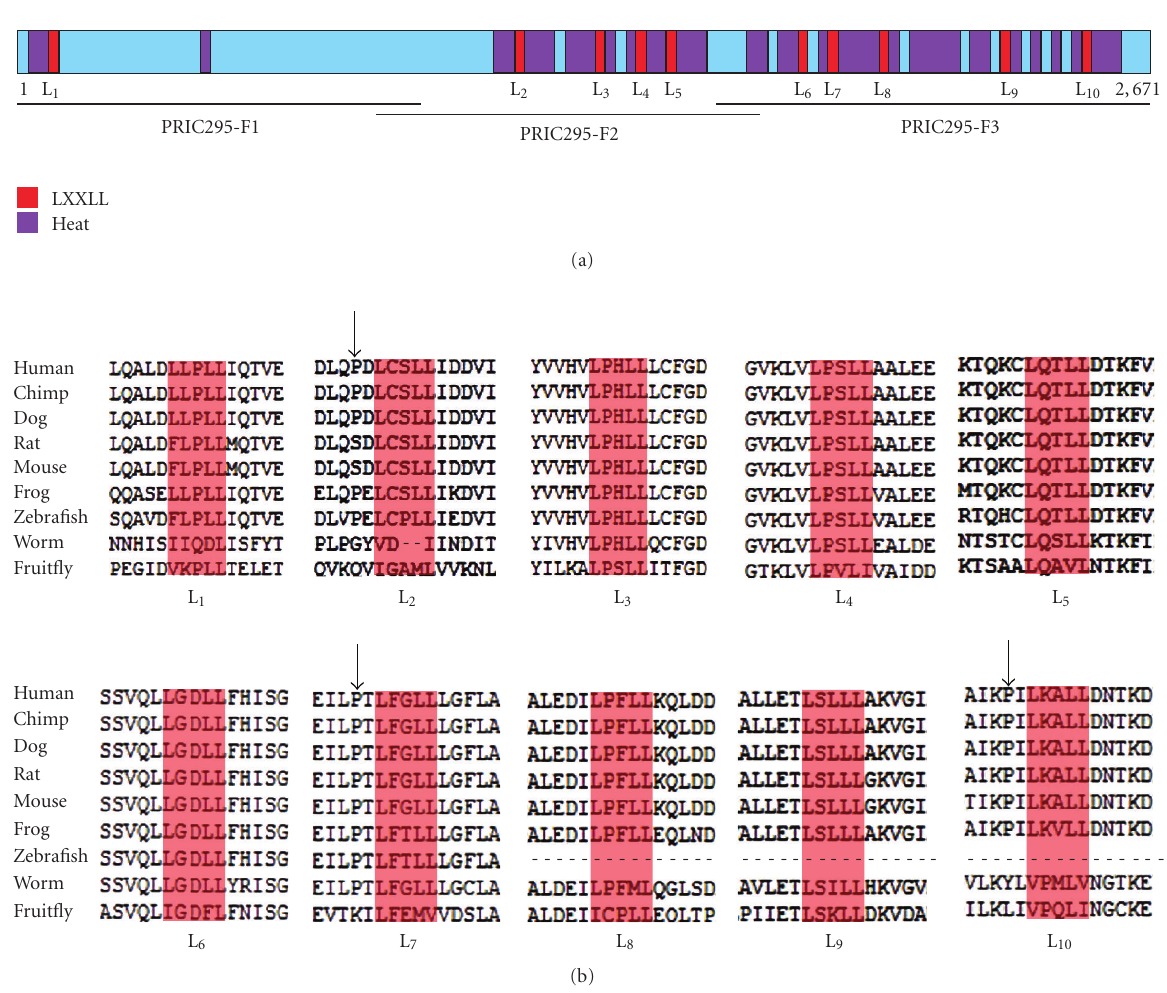
Figure 2: PRIC295 structural features. (a) Schematic representation of the PRIC295 protein to indicate the locations of LXXLL motifs in red color and HEAT repeat domains in purple color. (b) Alignment of the orthologous PRIC295 genomic sequences of selected species at the loci of all 10 of the LXXLL motifs contained in the human PRIC295 protein. LXXLLs are numbered L 1 to L 10 beginning from the N-terminal region: L 1 aa465–469; L 2 aa1160–1164; L 3 aa 1461–1465; L 4 aa1499–1503; L 5 aa1596–1600; L 6 aa1839–1843; L 7 aa1926–1930; L 8 aa2045–2049; L 9 aa2330–2334; L 10 aa2594–2598. The model organism to which each sequence corresponds is indicated at the left side of the sequence.